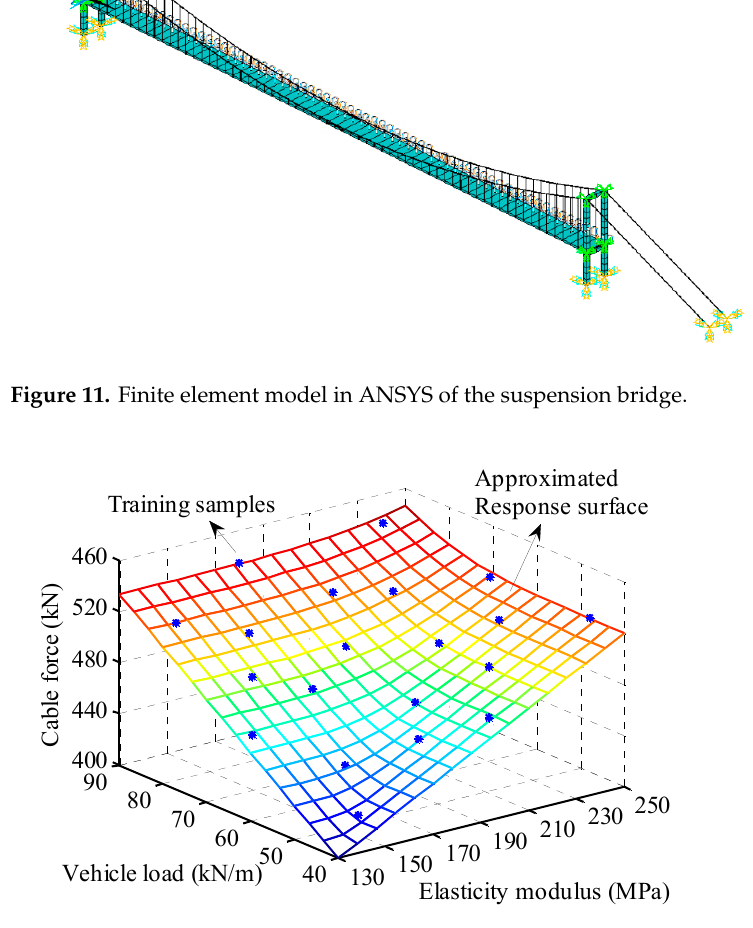
Figure 12. Simulated response surface and training samples of the cable force based on DBNs.